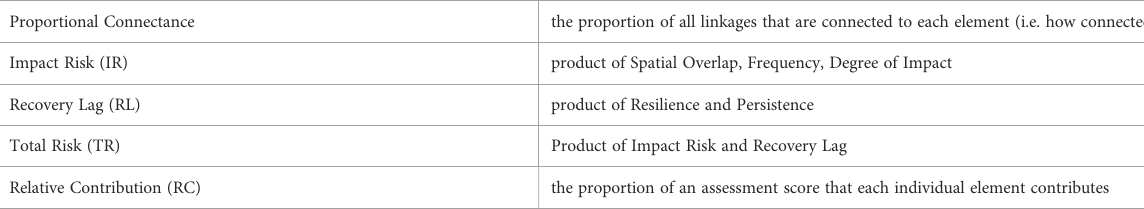
TABLE 2 Metrics used for analyses and reporting. Scores allocated as detailed in Table 1